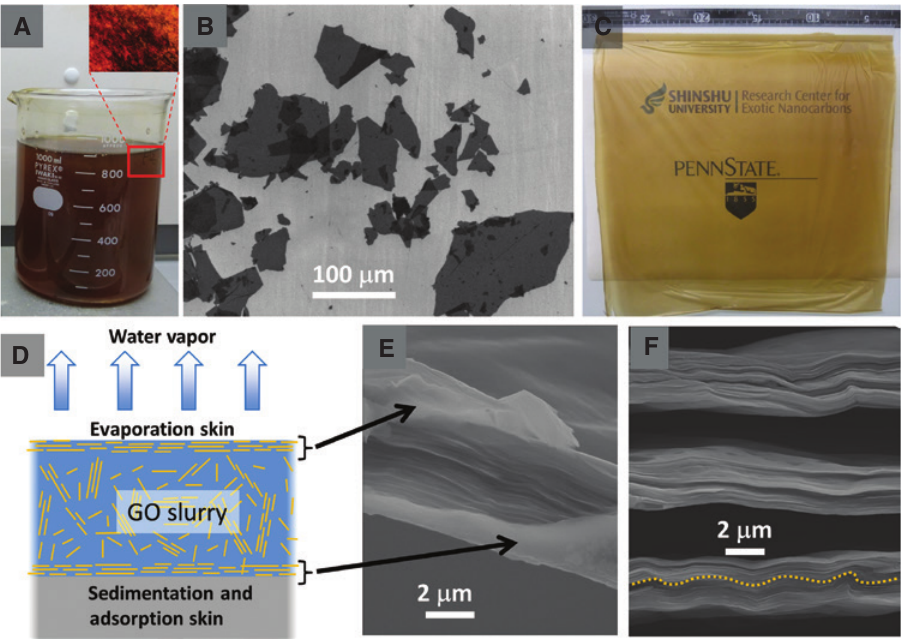
Figure 2: Graphene oxide films can be prepared by blade coating. (A) A 1-l beaker containing the GO slurry. The inset shows the dispersion under cross-polarizers. The red and green birefringences indicate the presence of liquid crystalline order in the dispersion. (B) The sheet size can be measured by SEM after drying the diluted GO dispersion. Sheets up to 100 μ m in lateral size can be observed. (C) Large-area freestanding GO film with a density of about 0.4 mg/cm 2 and average thickness of 1.4 μ m. The films do not tear easily and can be manipu- lated in ambient conditions. (D) Mechanism of drying of the GO film. (E) SEM cross-sectional image showing the formation of a “stronger” skin on both surfaces of a 4.7- μ m-thick film. The arrangement of the GO sheets parallel to film surface can be seen, and (F) shows the cross section of a GO film prepared by blade coating. The yellow line is added as a guide to show the waviness of the